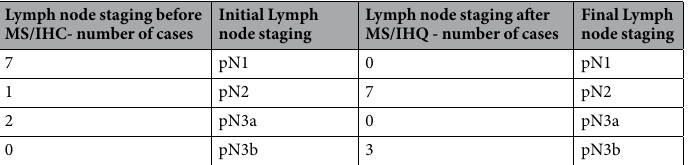
Table 2. Staging and restaging of lymph node involvement by micrometastases, after evaluation by IHC and MS in gastric cancer patients operated with known lymph node metastases by hematoxylin-eosin (n = 10). MS – Lymph node multisection, IHC – immunohistochemistry.